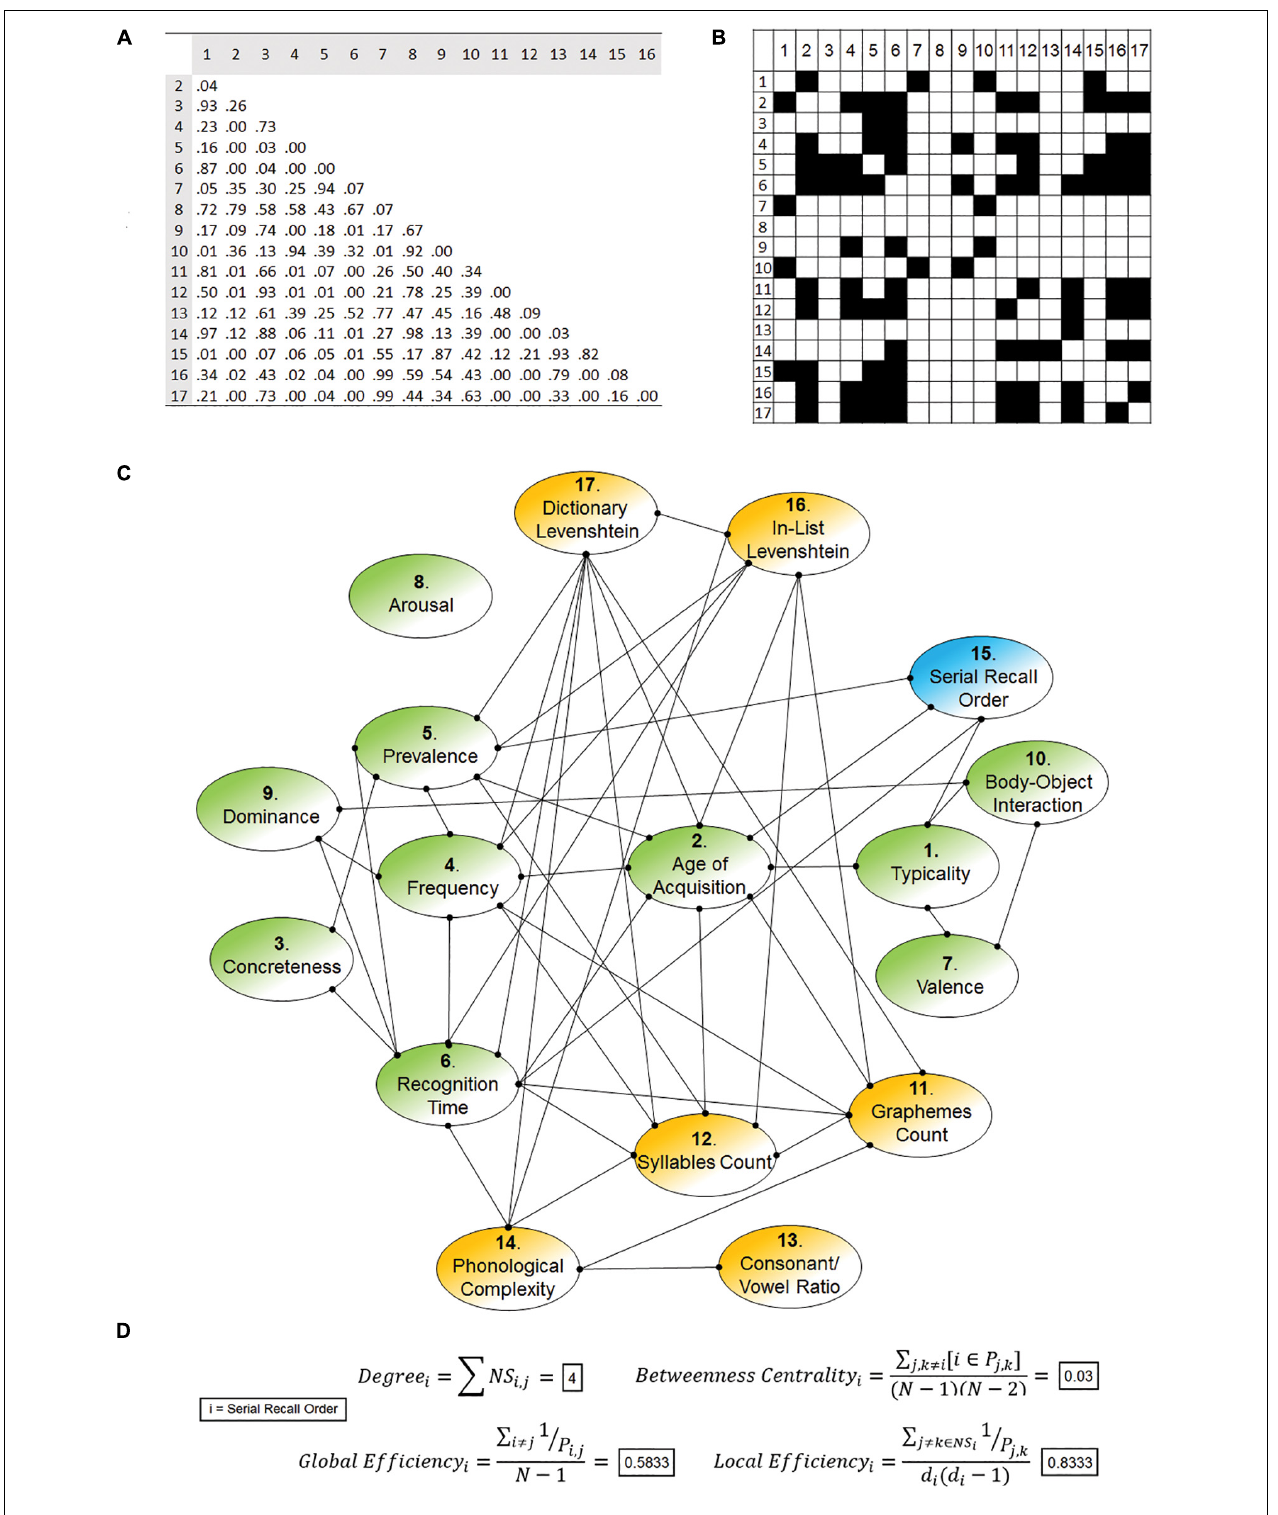
FIGURE 2 | Example of matrices and graph calculated on a single participant (a 71 year-old woman). The feature-to-feature correlational matrix (A) and the binary adjacency matrix tagging significant correlations (B) are shown. Please note that, since based on correlations, adjacency matrices express bidirectional relationships. The graph (C) colour-codes and distinguishes the node of interest (blue) from the ten semantic features (green) and the other non-semantic features (yellow). Nodal metrics of “serial recall order” (inclusive of formulas) for this specific participant are reported in the lower part of the image (D) .